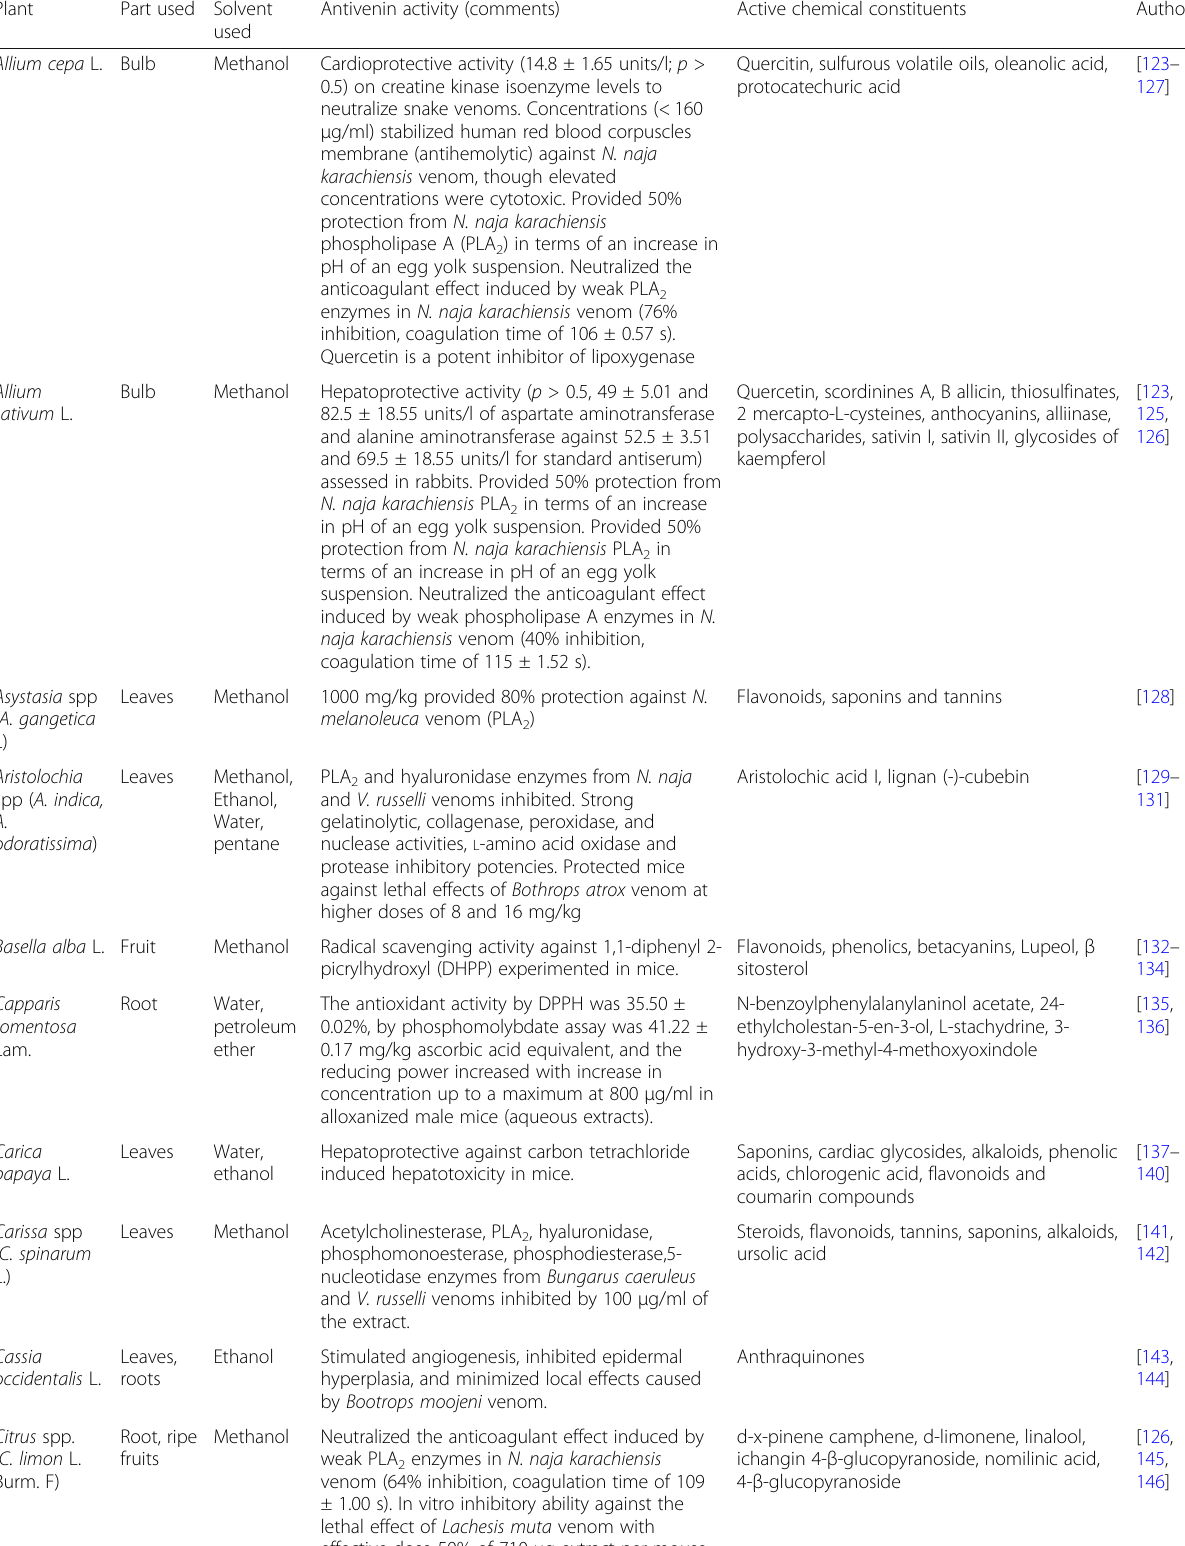
Table 3 Antivenin activities of some plants used for snakebite treatment in Uganda as per global reports Plant Part used Solvent Antivenin activity (comments) Authors used Allium cepa L. Bulb